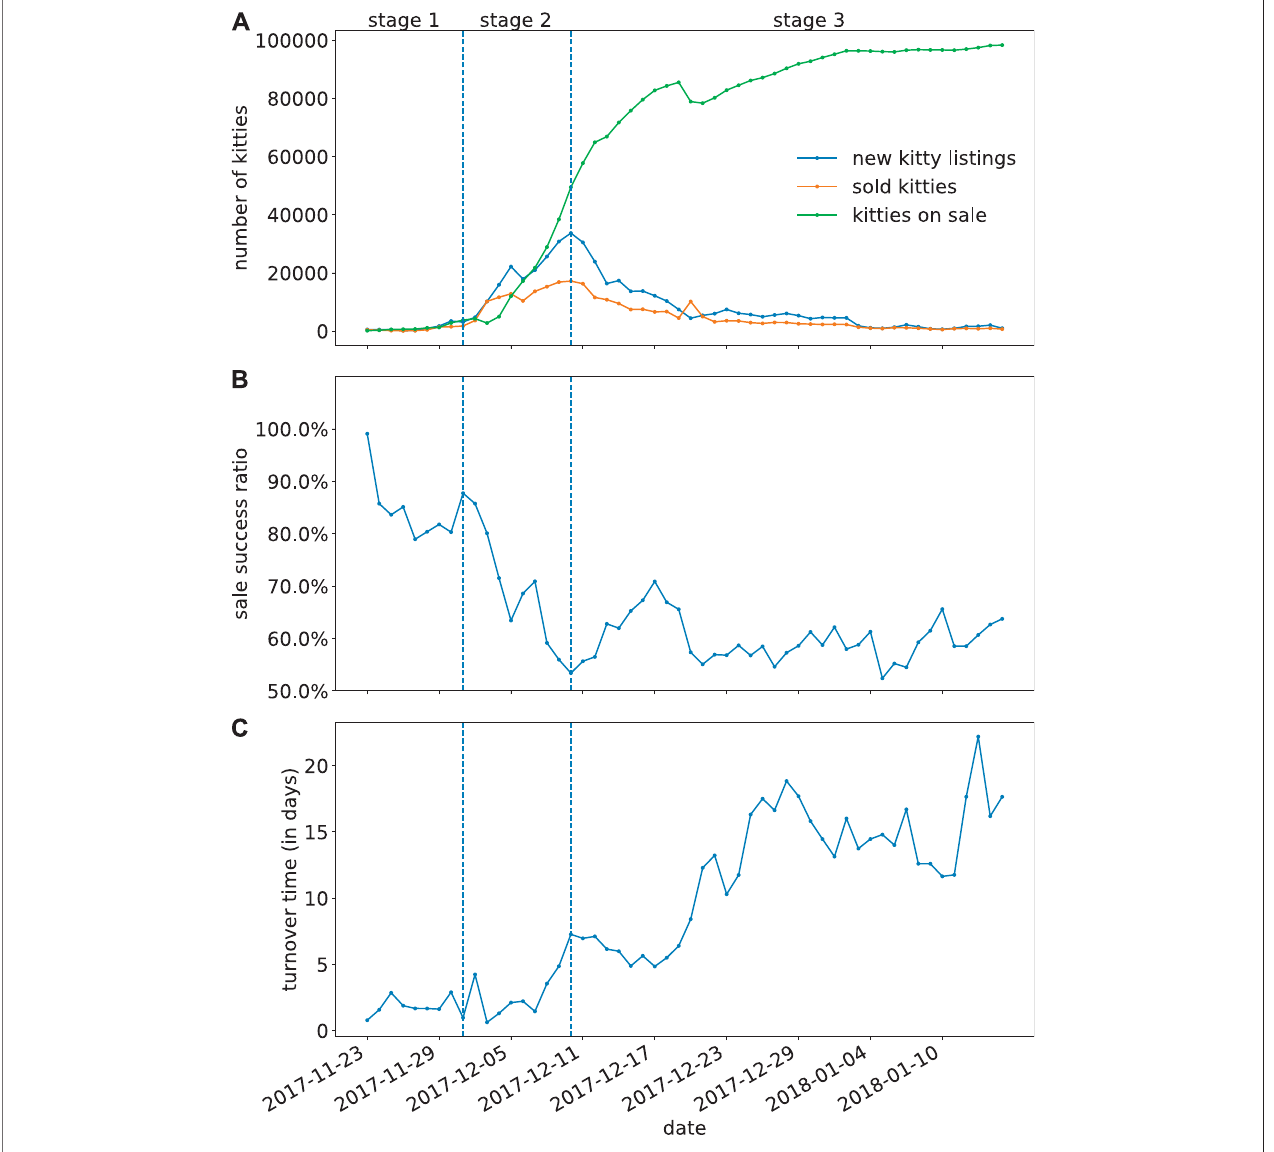
FIGURE 8 | The supply and demand of kitties in the market. (A) The numbers of new kitty listings, kitties sold, and kitties on sale in the market every day. (B) The ratio of successful sale for kitties listed on each day. (C) Turnover time, i.e., the average time interval between kitty listing and trade closing for kitties listed on each day. Dotted lines separates the stage 1, 2 and